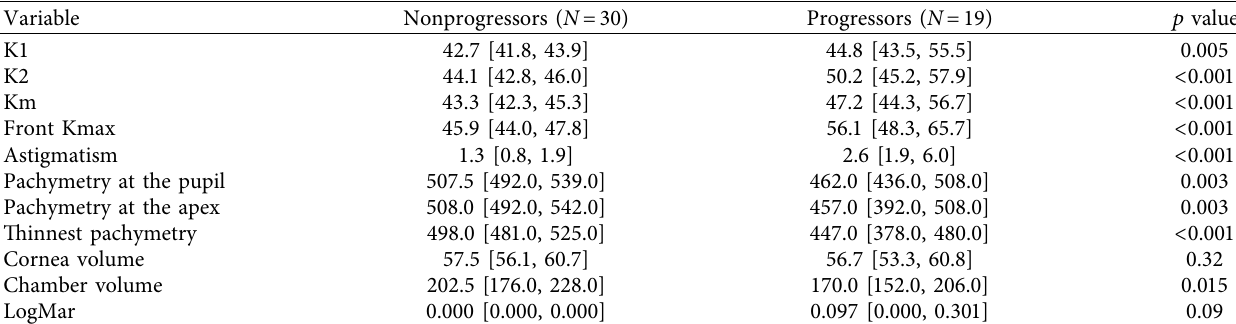
Table 3: Baseline disease metrics in progressing and nonprogressing na¨ıve fellow eyes (Group 2).